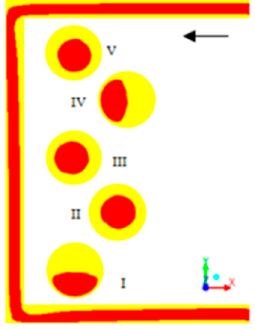
Figure 6. Rectangular bend [35]. (Red for oil and yellow for water.)